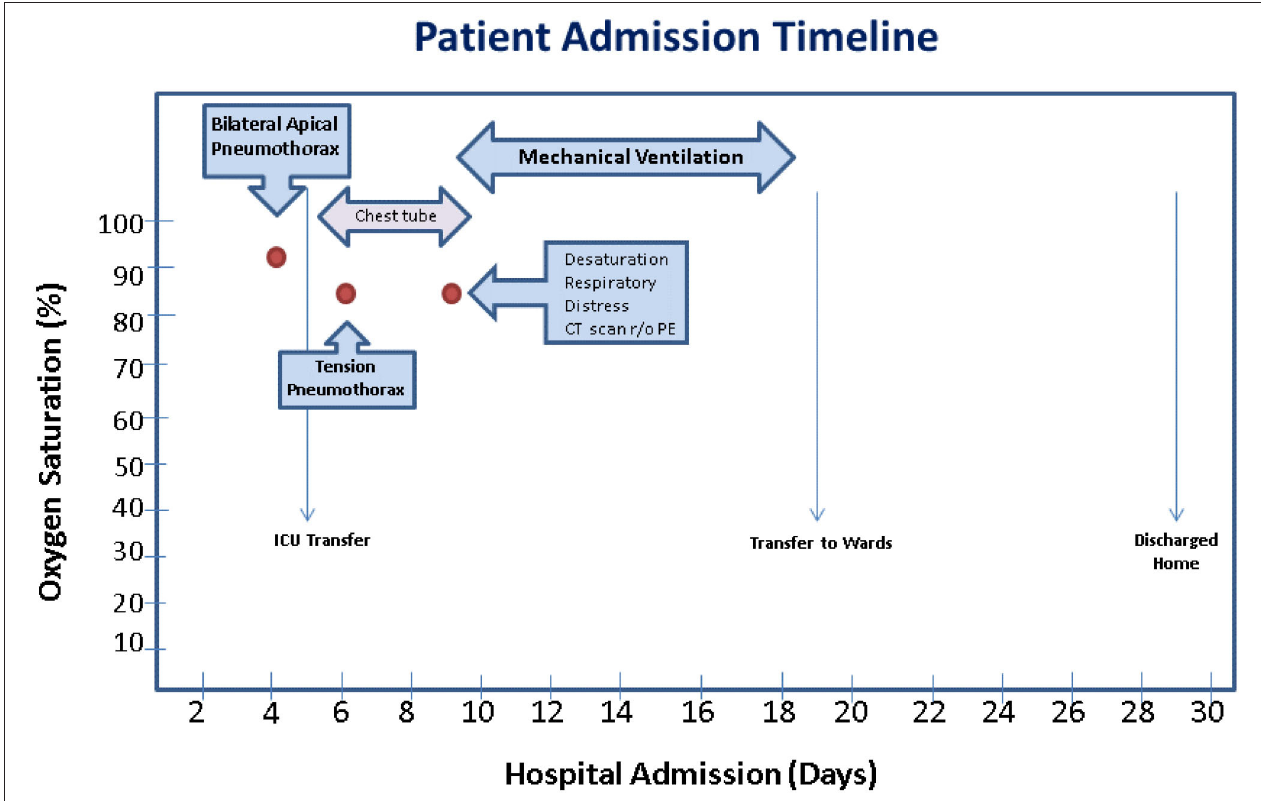
FIGURE 2 | Admission Timeline of a 60-year-old Black male with a past medical history of HIV infection with a CD 4 T cell count of 351 cells/mm 3 on HAART, HIV encephalopathy, hyperthyroidism, BMI 18.2 kg/m 2 , and no active smoking or respiratory disease presented to the hospital due to worsening confusion, cough, and generalized weakness, diagnosed with COVID-19 pneumonia and bilateral